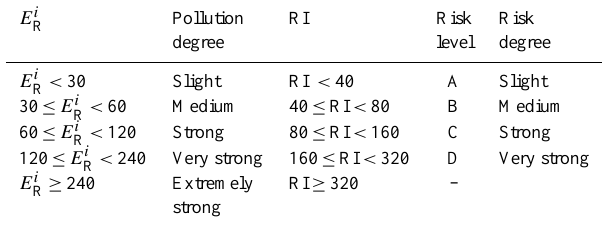
Table 1. The adjusted grading standard of potential ecological risk of heavy metals in soil. E i R Pollution